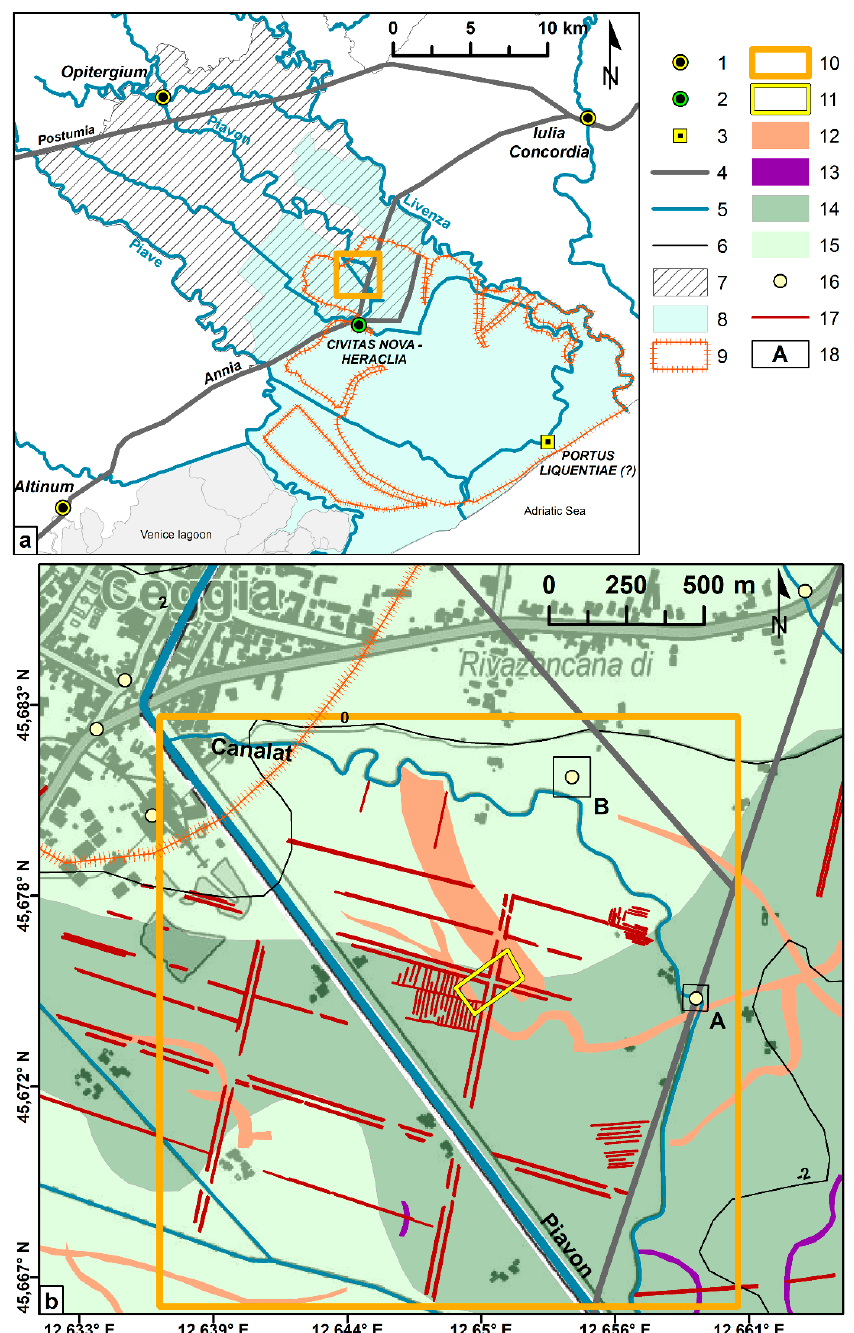
Figure 2. ( a ) Historical-topographical map; ( b ) Geoarchaeological map with traces from aerial photographs. Legend: (1) Roman cities; (2) Early Medieval towns; (3) probable site of the Roman port; (4) Roman roads; (5) main watercourses; (6) contour lines with equidistance 2 m; (7) southern countryside of Opitergium ; (8) mechanical drainage areas; (9) extension of marshy-lagoon areas from 17th century cartography; (10) study area; (11) area studied with geophysical surveys, core drilling, and cleaning of the exposed sections; (12) paleochannels; (13) ancient lagoon canals; (14) loamy soils; (15) clayey soils; (16) archaeological findings known from the bibliography [8,10] and from data archive of the SABAP modified by the authors; (17) anthropic aerial photo lines; (18) sites of particular interest: A-Roman bridge; B-probable rustic settlement. The geomorphological elements (12), (13), (14), and (15) are taken from [1].